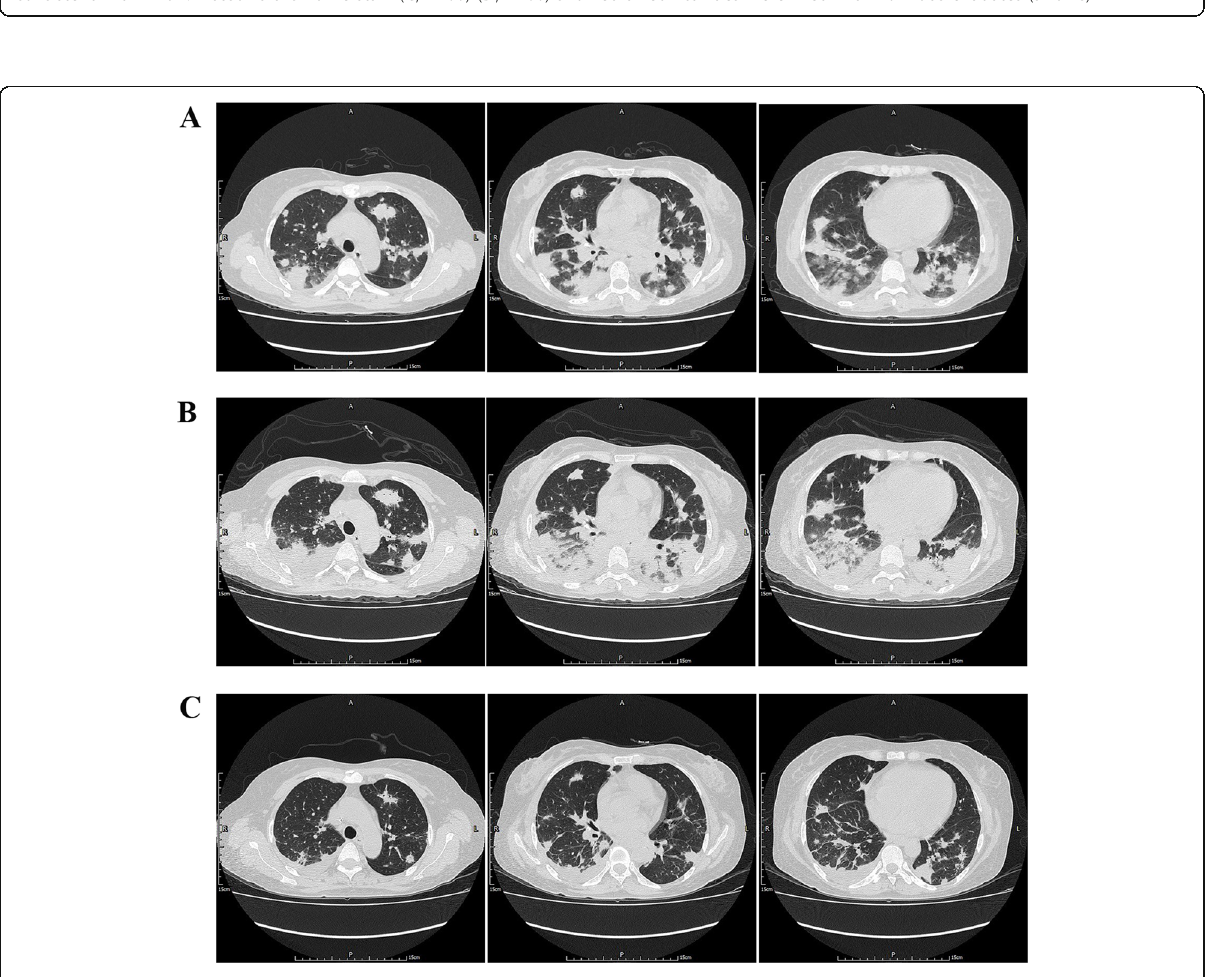
Fig. 3 The initial CT images and the follow-up CT images of case 2. A Chest CT on admission revealed multiple nodules, consolidations and patchy opacities in both lungs. B CT images on day 14th of admission showed bilateral lesions increased and enlarged. C CT images at the 7th day of the steroid treatment showed absorption of bilateral lung